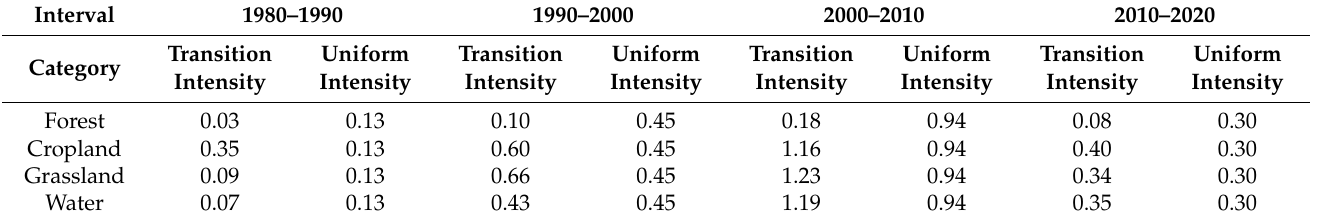
Table 20. Transition to Built-up Area.